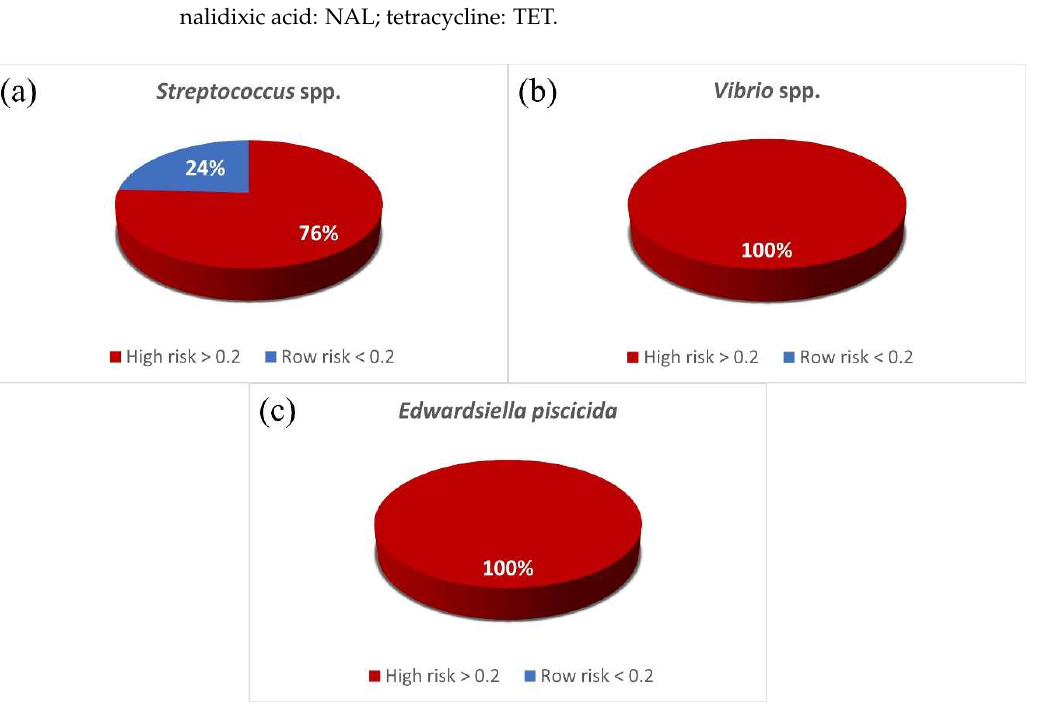
Figure 4. Classification of isolates by MAR index. High risk (red area) means that the isolate has a MAR index greater than 0.2 derived from a high-risk source of antibiotic contamination [23]: ( a ) Streptococcus spp.; ( b ) Vibrio spp.; ( c ) Edwardsiella piscicida .